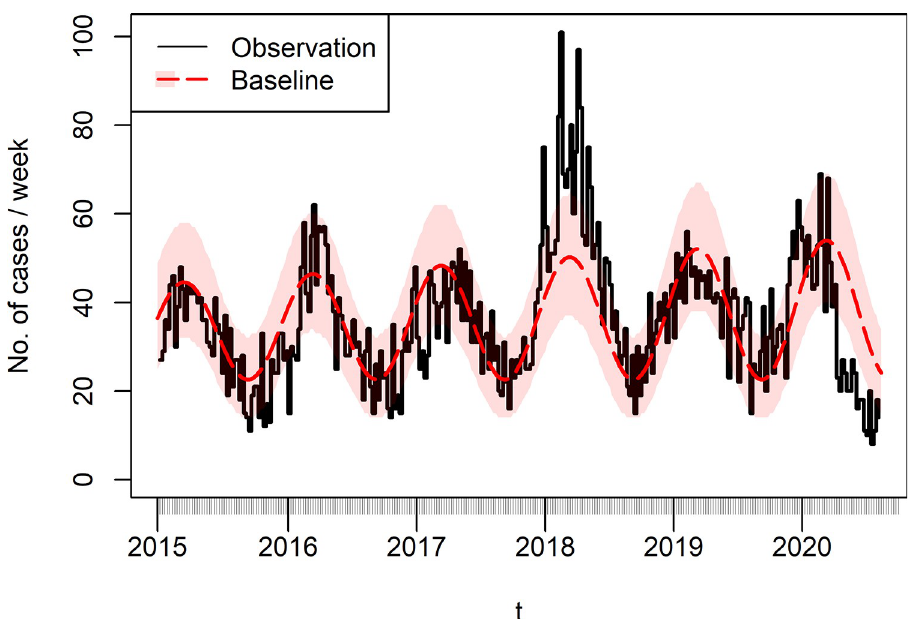
Fig 5. Weekly number of iGAS infection cases (black solid line) and fitted temporal baseline function λ red line, shaded area comprises 95% confidence interval). 2018 was a year of heightened transmission across England, as reported in [56]. The overall fitted trend is increasing, despite the sharp drop in